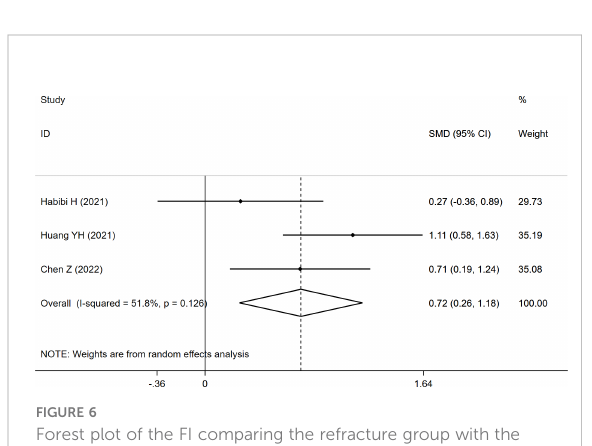
FIGURE 6 Forest plot of the FI comparing the refracture group with the non-refracture group.